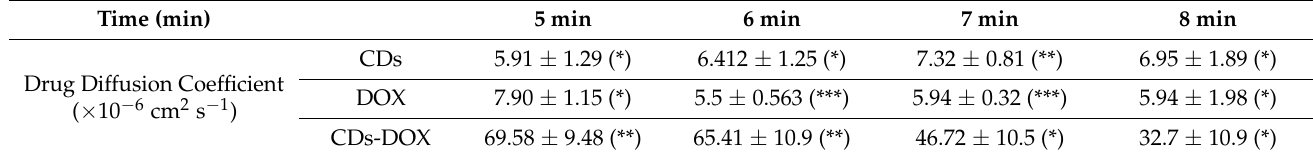
Figure 4. The diffusion time and the number of particles of CDs, DOX and CDs-DOX diffusing across the U 2 OS cell membrane at pH 6 ( A , B ) and pH 5 ( C , D ). HCl was added to adjust the pH value of the cell medium, and the pH value was measured with pH test paper, followed by incubation for 10 min prior to FCS experiments. Error bars represent the standard deviation of 9 measurements. Table 1. Summary of the mean diffusion coefficients of CDs, DOX and CDs-DOX with standard errors on the mean at pH 5 from 5 min to 8 min (n = 9). “ * ” indicates that at the level of p < 0.05, there is no significant difference between the overall mean and the test mean. “**” indicates that at the level of p < 0.001, there is no significant difference between the overall mean and the test mean. “***” indicates that at the level of p < 0.001, there is no significant difference between the overall mean and the test mean.